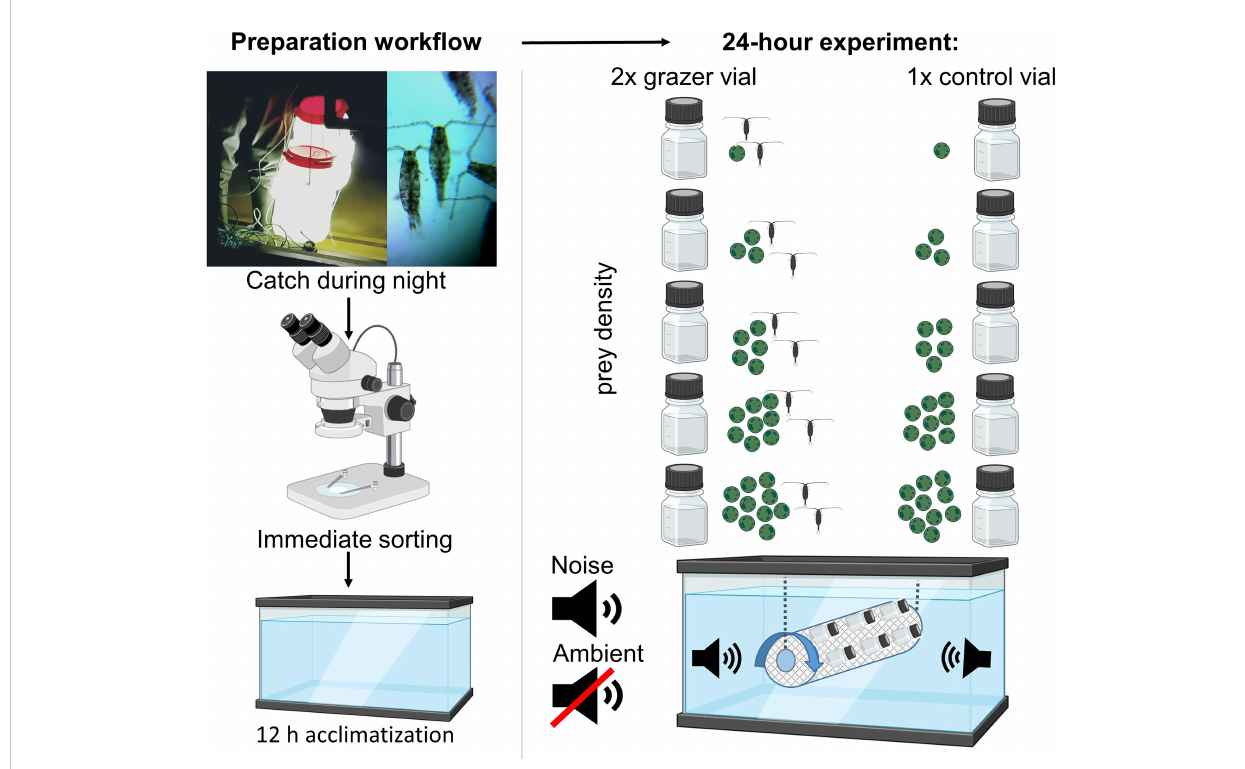
FIGURE 1 Overview Experimental Setup. Left column: preparation work fl ow. Capture of copepods Acartia tonsa using light traps at night. Immediate sorting under the stereoscope, and 12 h acclimatization in the dark. Right column: experimental design. Preparation of fi ve different phytoplankton cell concentrations (1000 – 10000 cells ml − 1 ) using Tetraselmis chuii as prey and fi lled in experimental vials: control vials and grazer vials. Groups of copepods were then added to the grazer vials after Almeda et al. (2018). Both control and grazer vials with all different cell concentrations were then mounted to an underwater phytoplankton wheel and incubated for 24 hours exposed to either ambient sound or harbor noise playbacks. Partly created with